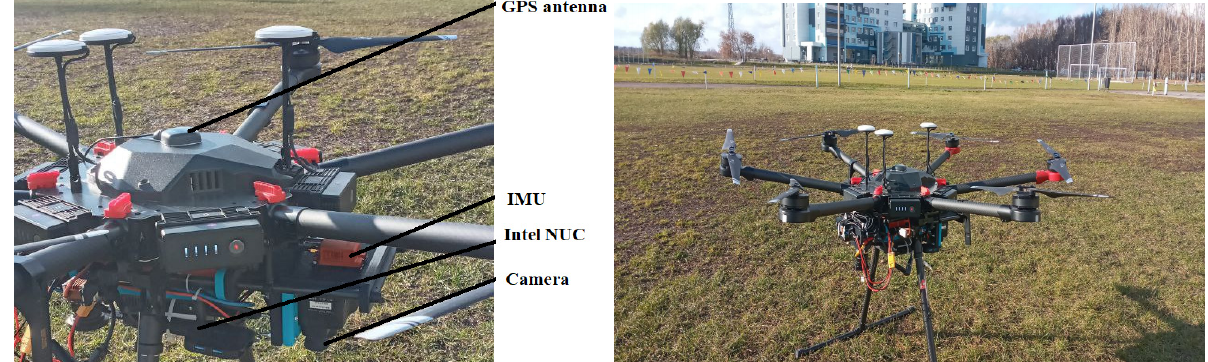
Figure 1. The DJI Matrice Pro 600 at the launch point is shown in the right image. The attached equipment on the drone is shown in the left